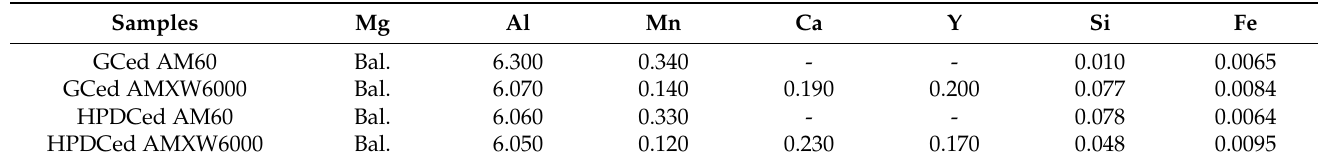
Table 1. The chemical composition (in wt%) of AM60 and AMXW6000 alloys by GC and HPDC. Samples